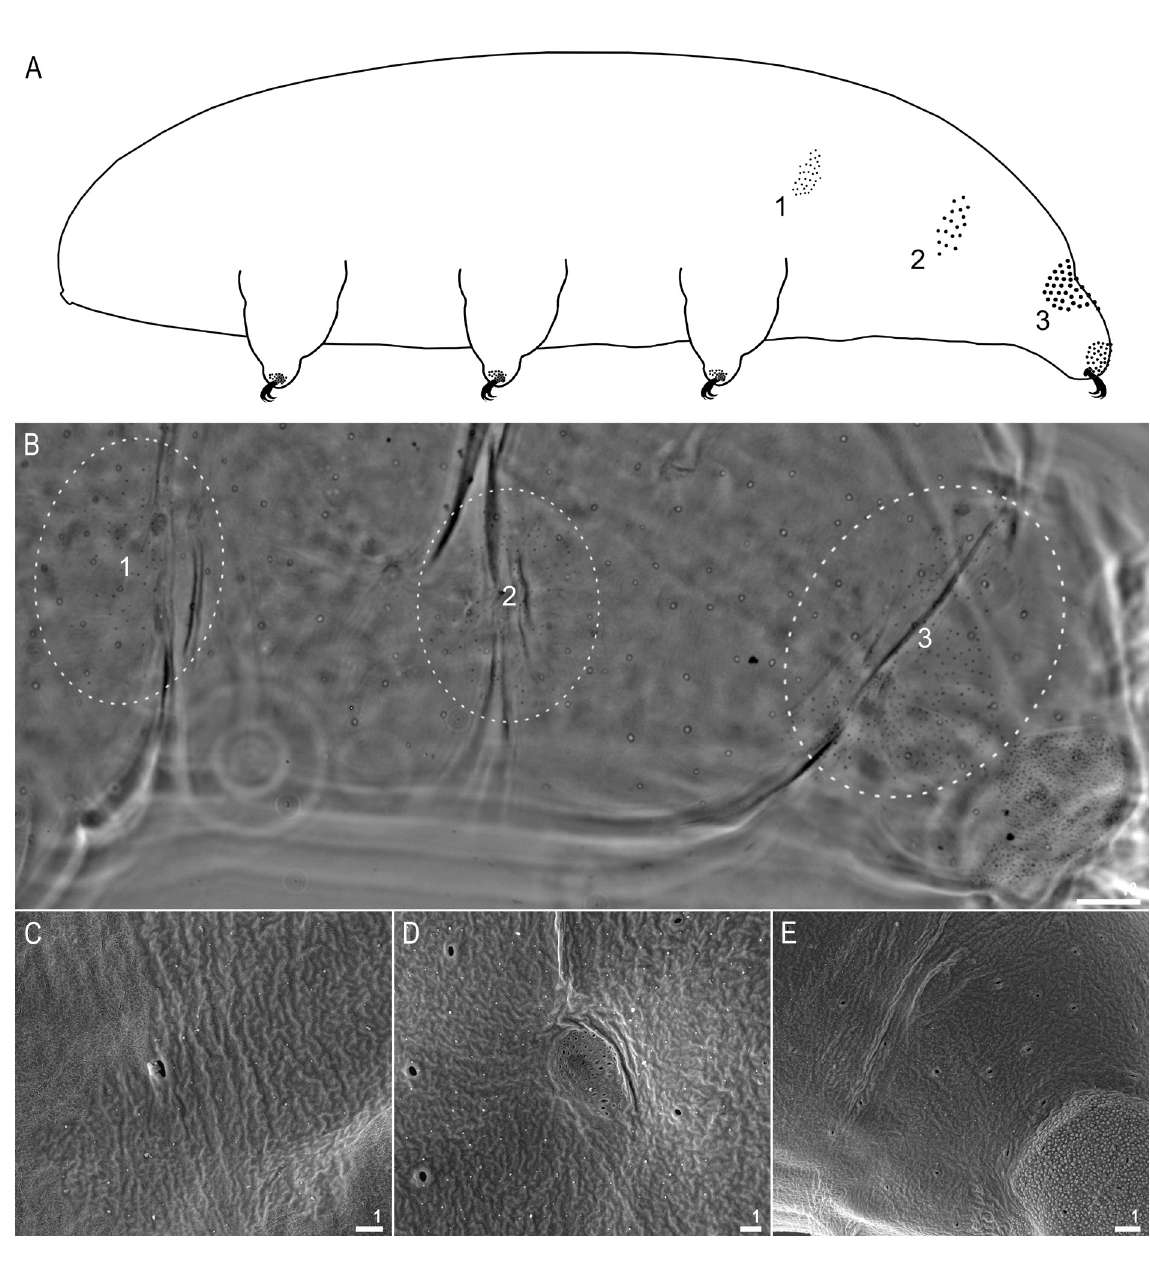
Fig. 10. Macrobiotus kamilae sp. nov., dorso-lateral patches of body granulation (paratypes, IZiBB). A . A semi-schematic drawing of a laterally positioned animal showing all patches of cuticular granu- lation: numbers indicate three dorso-lateral patches of body granulation (the granule sizes are not to scale, they have been enlarged in order to make them identifiable on the drawing). B . Three patches of dorso-lateral granulation visible in PCM. C–E . Magnifications of three patches of dorso-lateral granulation visible in SEM (C–E correspond to the patch numbers presented above). Please also note a cribriform area, which is external evidence of a muscle attachment in the centre of Fig. 10D. Scale bars in